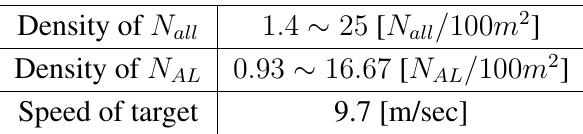
Table 4. Simulation